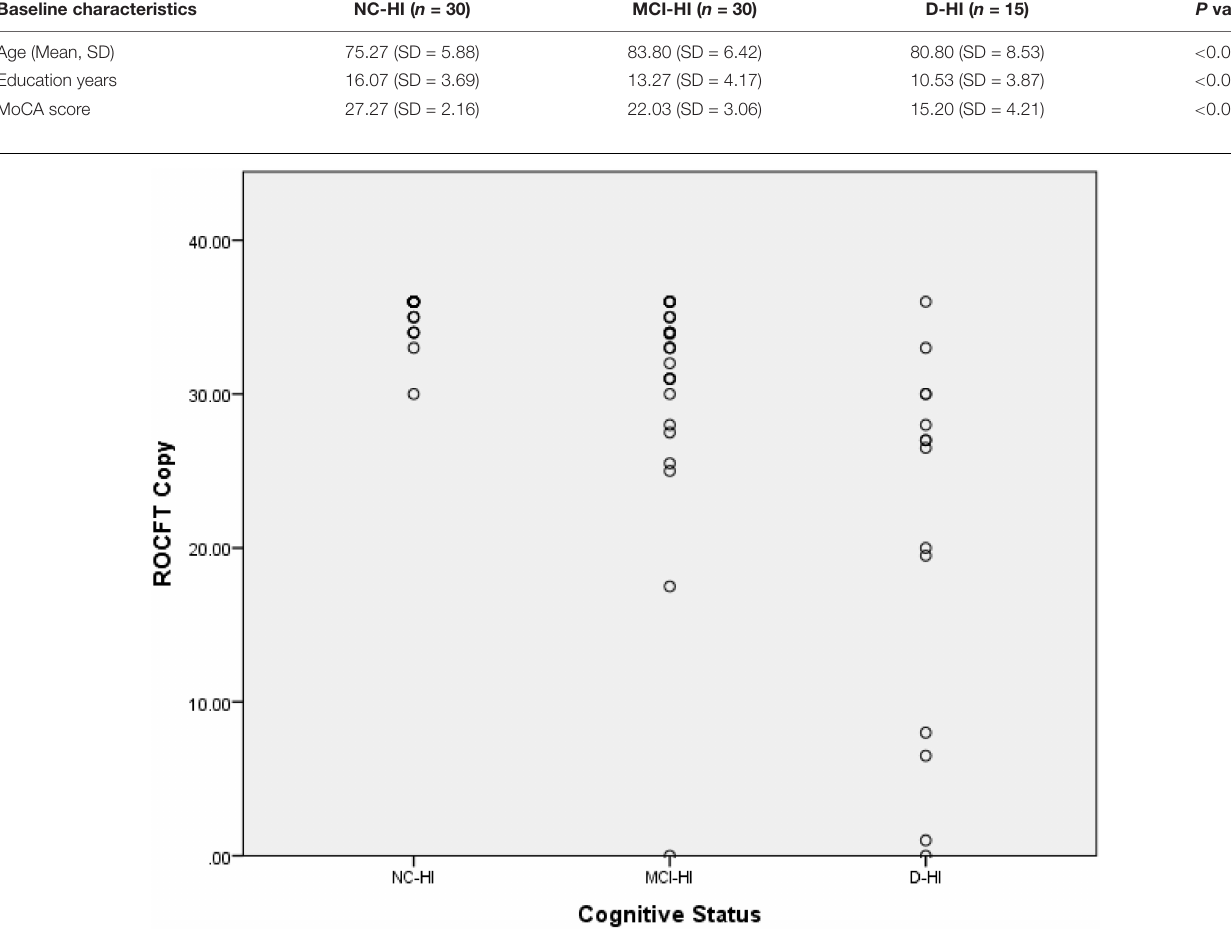
FIGURE 1 | Scatter plot for the ROCFT copy scores of the three